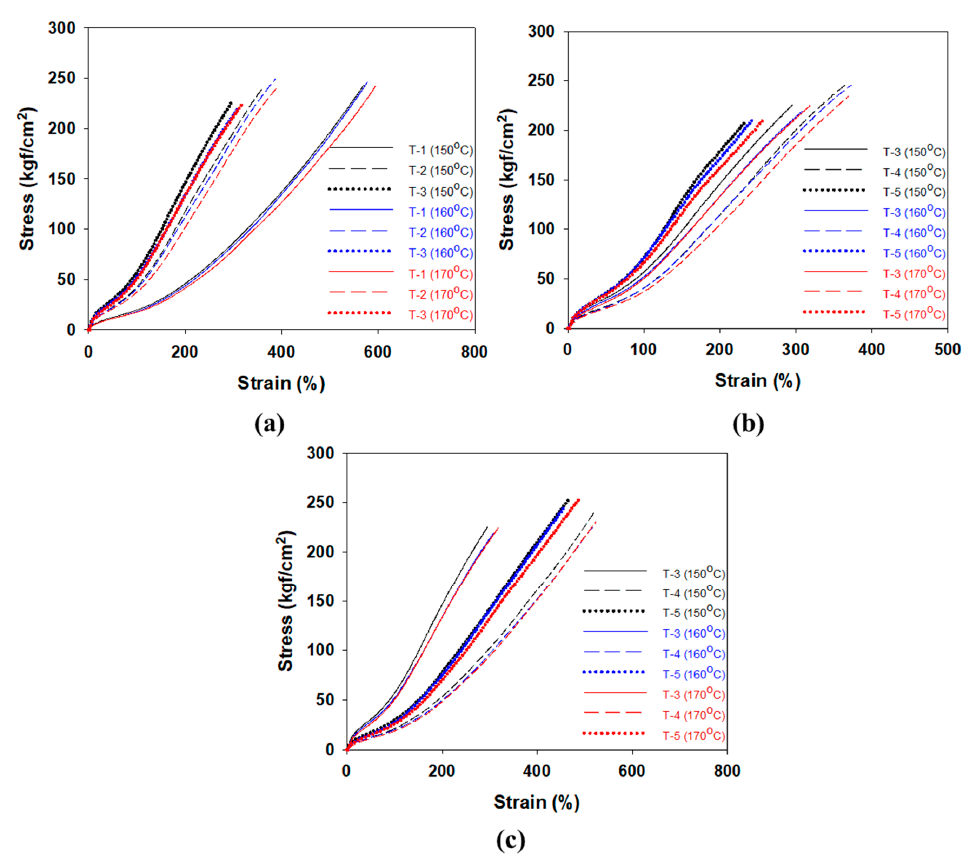
Figure 8. Stress–strain curves of the vulcanizates by different cure temperature; ( a ) T-1,2,3, ( b ) T-3,4,5, and ( c ) T-3,6,7.